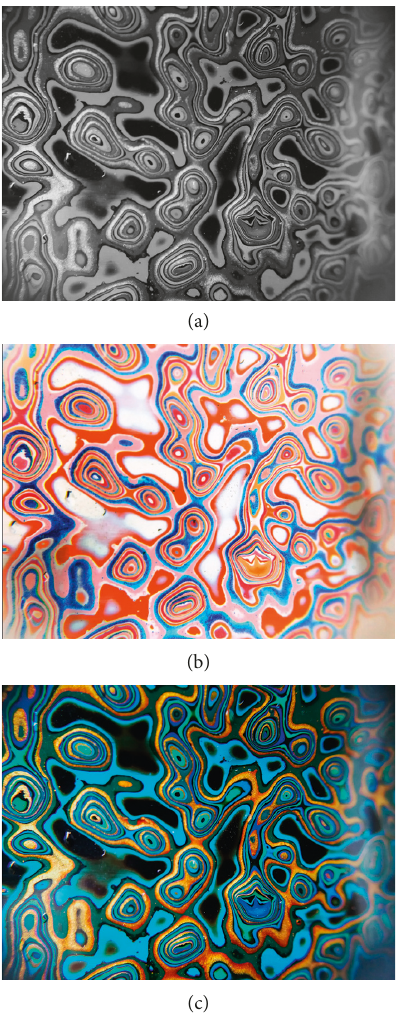
Figure 9: Artwork design case. (a) Drawing of sketches. (b) Preliminary rendering. (c) Design finished product. Table 1: Effect verification of handicraft structure design system based on dynamic simulation